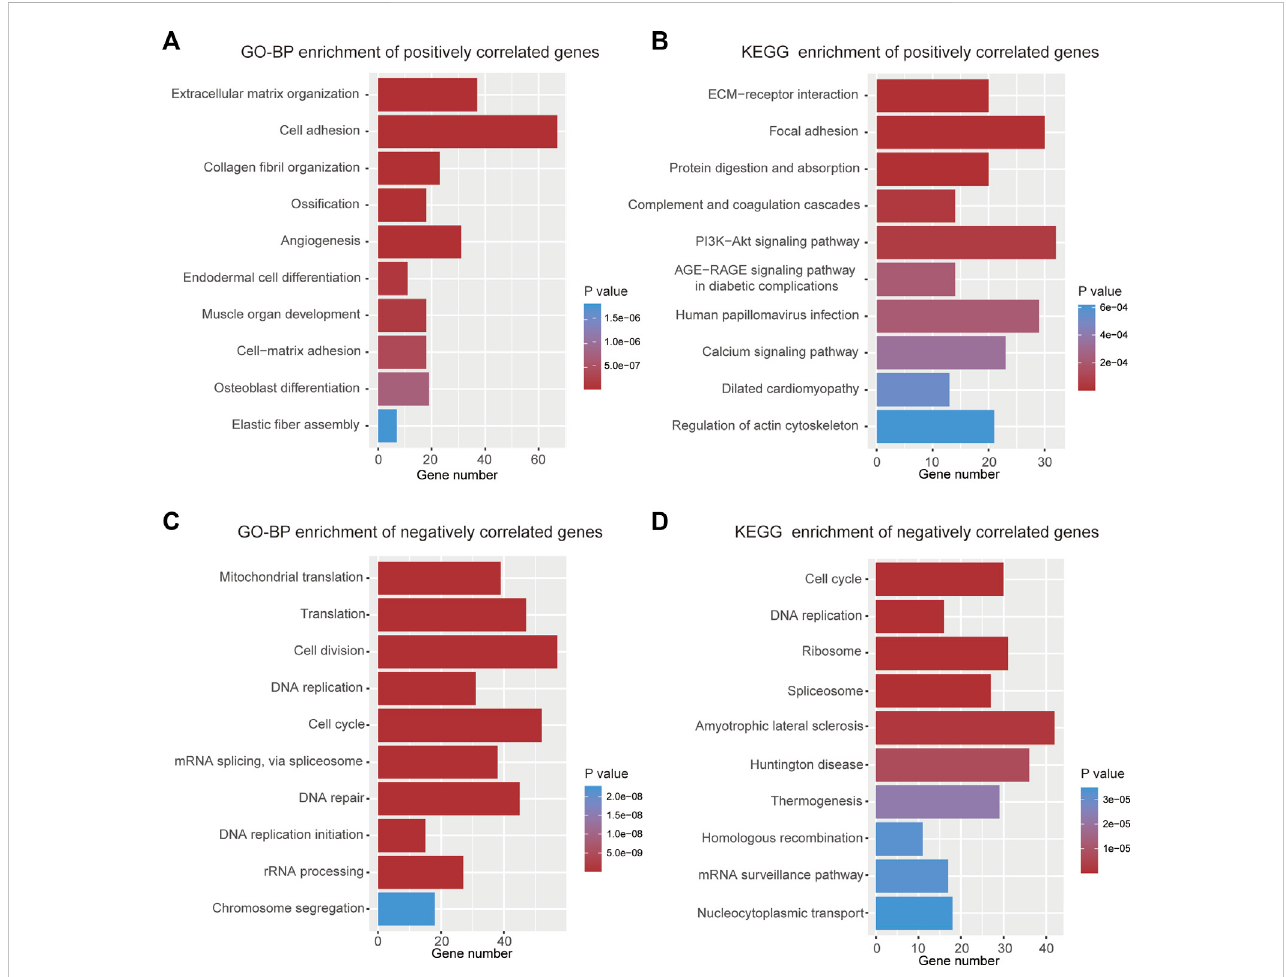
FIGURE 6 Functionalanalysesofthe9-genesignature. (A) Top10termsofGO-BPanalysisforgeneswithpositivecorrelation. (B) Top10termsofKEGGanalysisfor genes with positive correlation. (C) Top 10 terms of GO-BP analysis for genes with negative correlation. (D) Top 10 terms of KEGG analysis for genes with negative